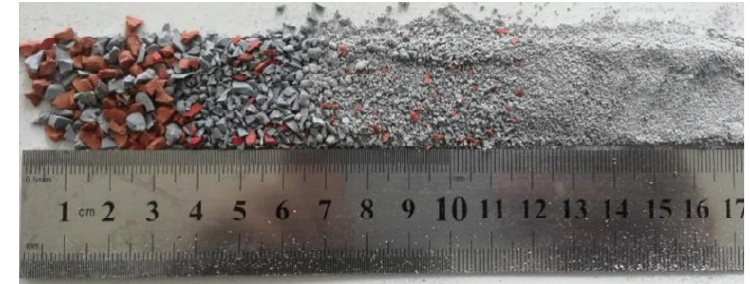
Figure 3. Silicone rubber particles